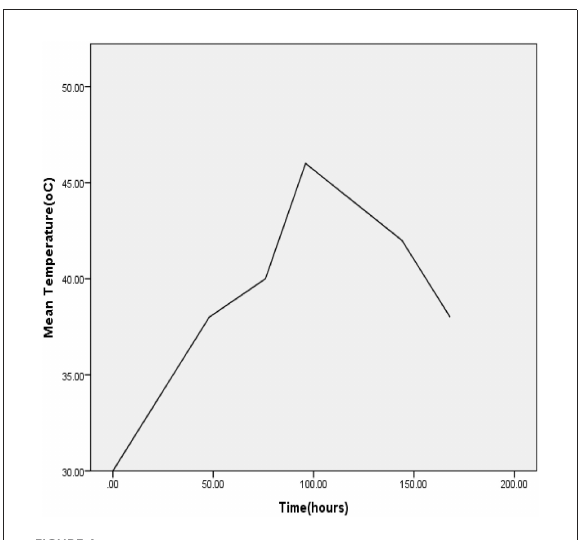
FIGURE4 Changes in temperature during the box fermentation of cocoa.